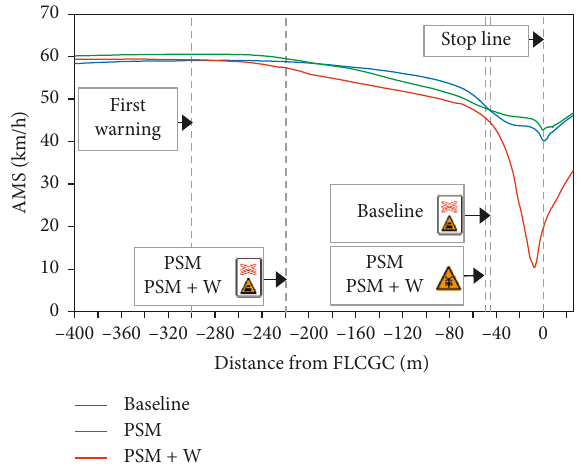
Figure 16: Approaching mean speed profiles of violation when the FLTT was